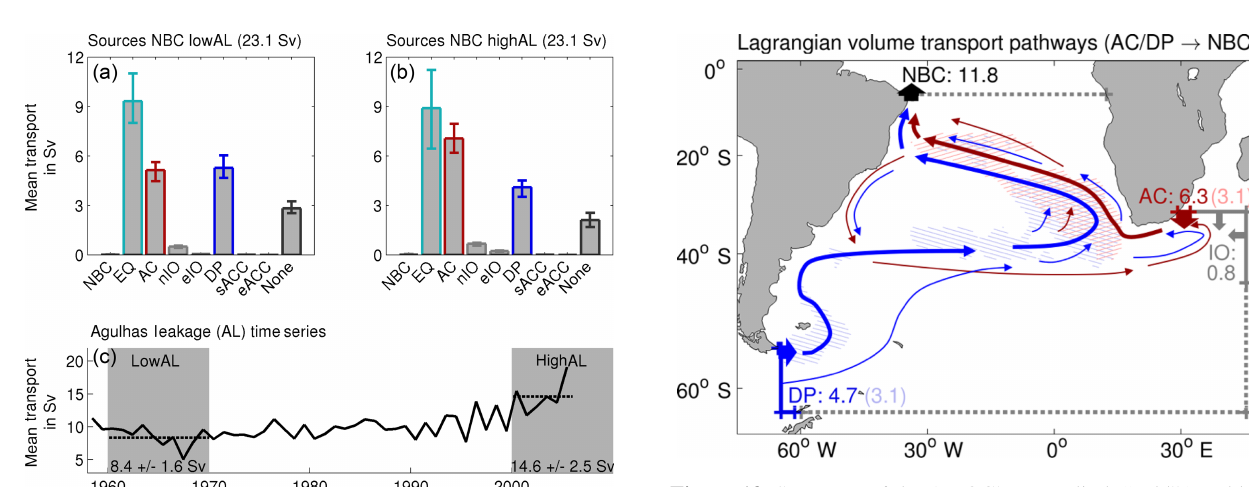
Figure 13. Summary of the AMOC’s upper limb “cold”(DP, blue) and “warm” (mainly AC, red) water routes inferred from O ( 10 6 ) simulated Lagrangian particle trajectories (REF experiments): ma- jor (thick arrows) and minor (thin arrows) advective pathways; La- grangian mean cross section transports in Sverdrups (numbers); respective volumetric contribution of particles entering the mixed layer at least once during the transit (numbers in brackets); and most likely areas of last mixed layer contact (hatching, same as in Fig.